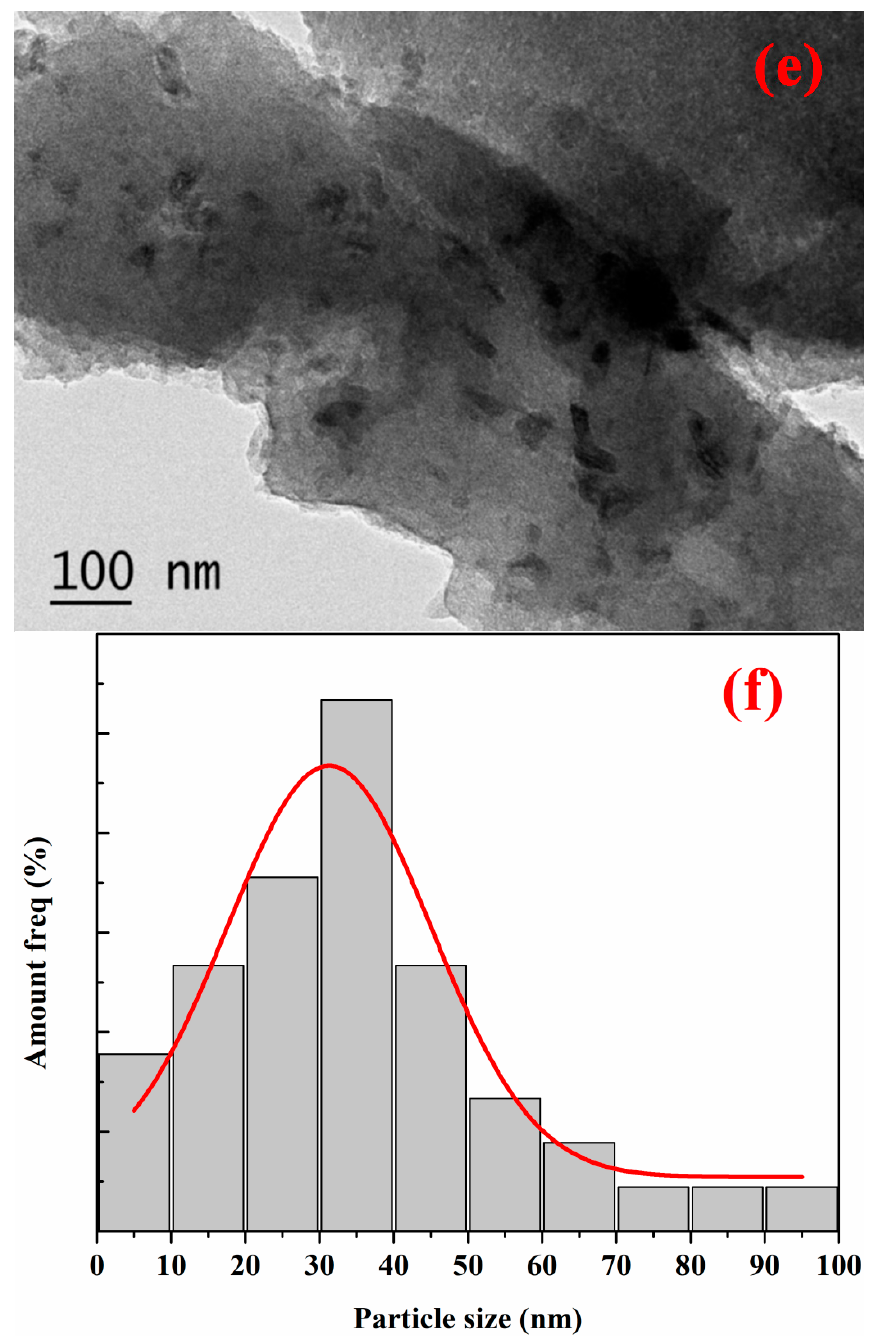
Figure 3. ( a , b ) SEM image of HTO-D201; ( c ) the radial distribution of Ti; ( d ) the radial distribution of P; ( e ) TEM image of HTO-D201; ( f ) particle size distribution histograms of HTO-D201.